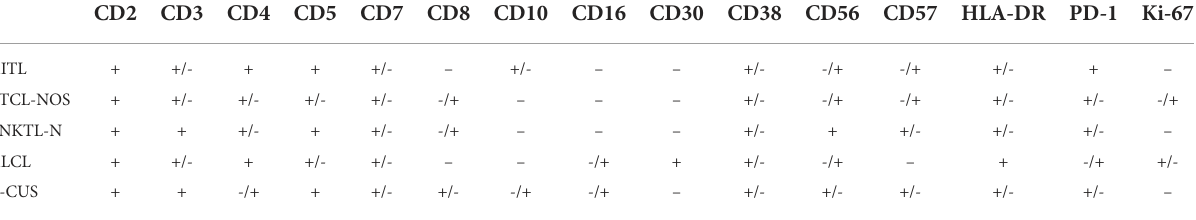
TABLE 1 Summary of typical immunophenotypic characteristics of AITL, PTCL-NOS, ENKTL, ALCL and T-CUS.